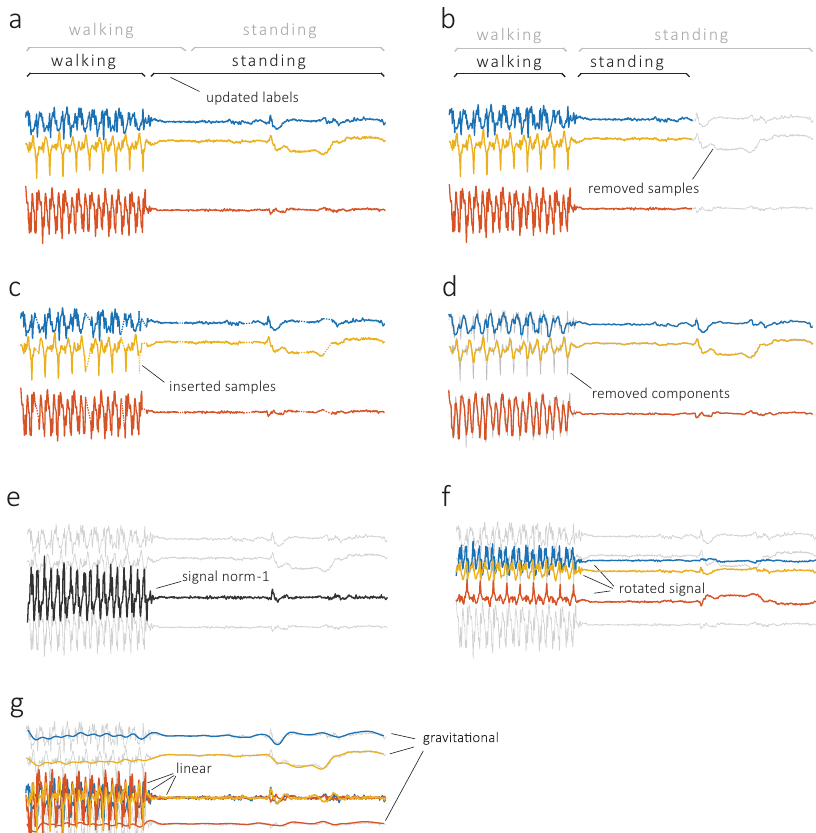
Fig. 8 Common data preprocessing steps include standardization and transformation. Standardization includes relabeling ( a ), when labels are reassigned to better match transitions between activities; trimming ( b ), when part of the signal is removed to balance the dataset for system training; interpolation ( c ), when missing data are fi lled in based on adjacent observations; and denoising ( d ), when the signal is fi ltered from redundant components. The transformation includes normalization ( e ), when the signal is normalized to unidimensional vector magnitude; rotation ( f ), when the signal is rotated to a different coordinate system; and separation ( g ), when the signal is separated into linear and gravitational components. Raw accelerometer data are shown in gray, and preprocessed data are shown using different